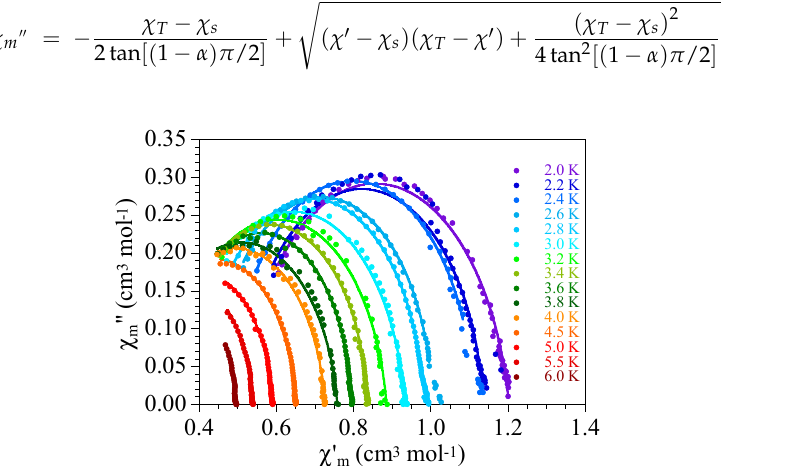
Figure 8. χ m (cid:48) vs. χ m ” plot for compound 1 at different temperatures. Solid lines are the fit to the Figure 8. χ m ′ vs. χ m ′′ plot for compound 1 at different temperatures. Solid lines are the fit to the generalized Debye model (Equation (4)). generalized Debye model (Equation (4)). Table 3. Parameters obtained from the fit of the out-of-phase AC signal ( χ m ′′ ) of compound 1 to the Debye model (Equations (2) and (3)).